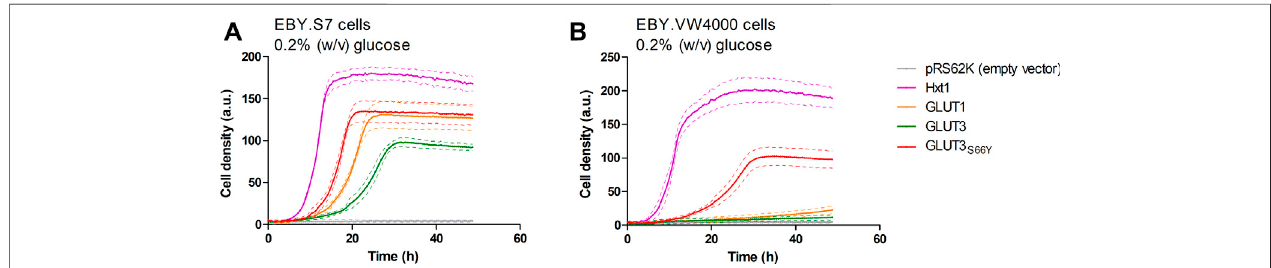
FIGURE 1 | Growth of hxt 0 cells expressing GLUT3 or GLUT3 S66Y on glucose. Cell growth of EBY.S7 (A) or EBY.VW4000 (B) cells in the YEP medium containing 200 µg/ml G418 and 0.2% (w/v) glucose was recorded with the Cell Growth Quanti fi er (Aquila Biolabs). The cells were transformed with the empty pRS62K vector, pRS62K vector or with plasmids encoding the endogenous Hxt1 the endogenous Hxt1 transporter, GLUT1, GLUT3, or GLUT3 S66Y . The average of three biological replicates (continuous lines) and the error (dashed lines) are shown. Apparent maximal growth rates for the growing cells were calculated with the CGQuant software and are listed together with the duration of lag phases in Supplementary Table